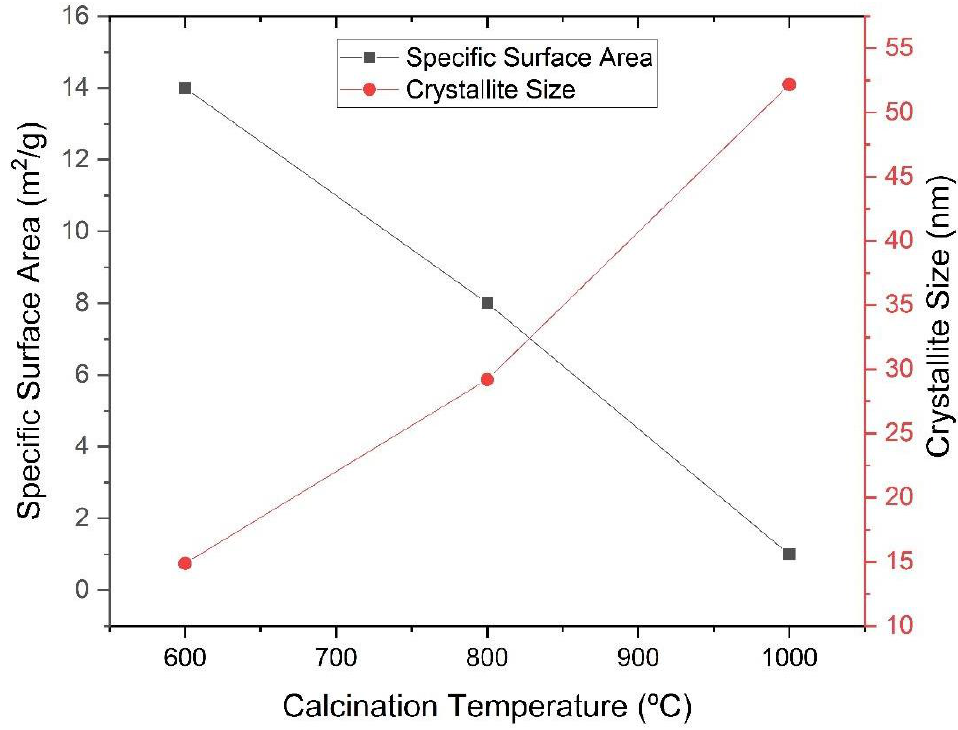
Figure 7. Specific surface area and crystallite size as a function of the calcination temperature of the powders obtained by the sol-gel method and heat-treated at different temperatures (600 °C, 800 °C and 1000 °C).